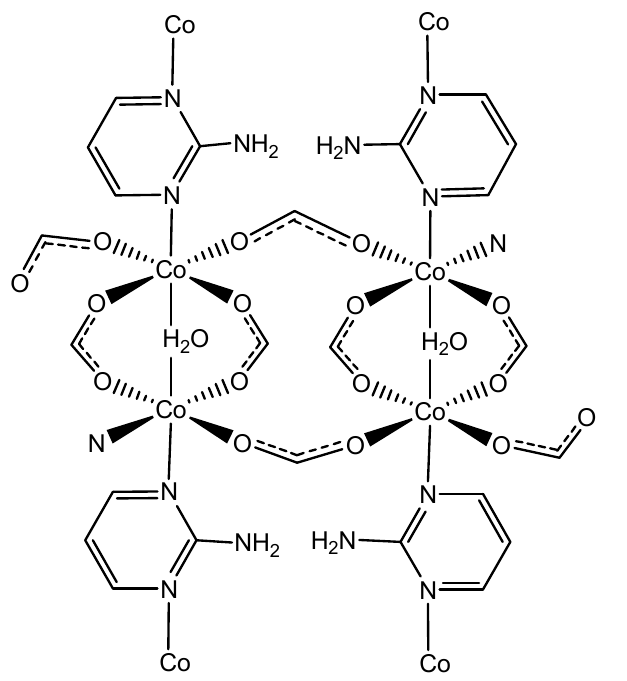
Scheme 1. Connectivity of Co and ligands (water, trans -cinnamate, and 2-aminopyrimidine) in forming chains. Only the carboxylate group in the trans -cinnamate and the N atom in the terminal 2-aminopyrimidine are shown for clarity.